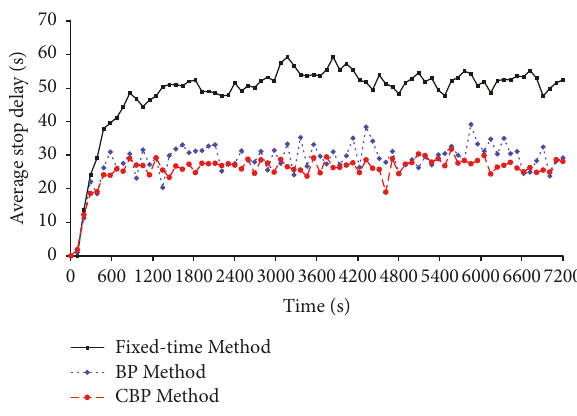
Figure 10: Average stop delay during simulation.